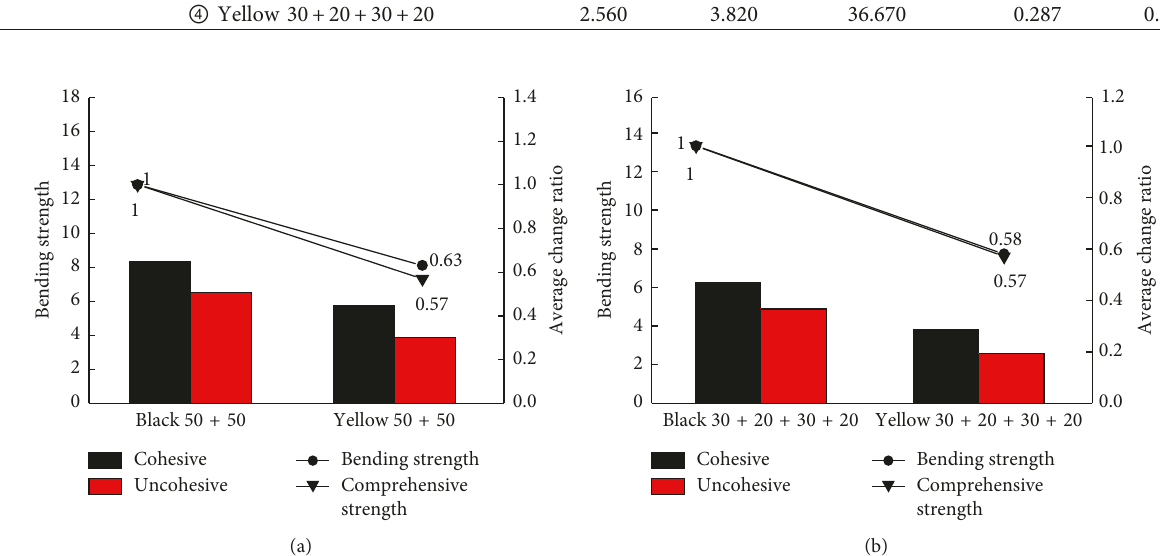
Figure 3: Contrast diagrams of bending strengths of different lithology of strata: (a) two layers; (b) four layers.